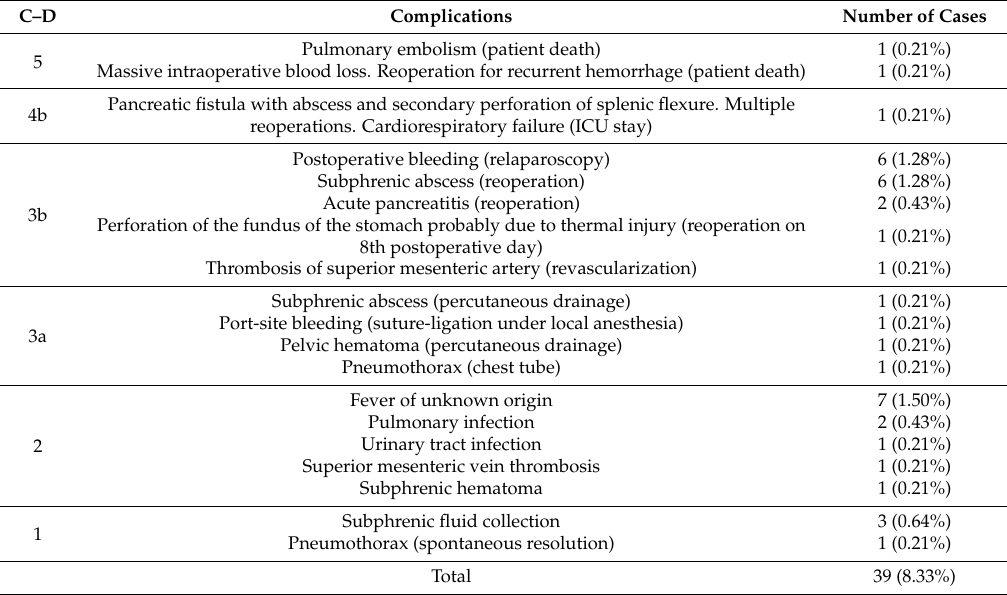
Table 5. Perioperative ( ≤ 30 days) complications according to Clavien–Dindo grading.